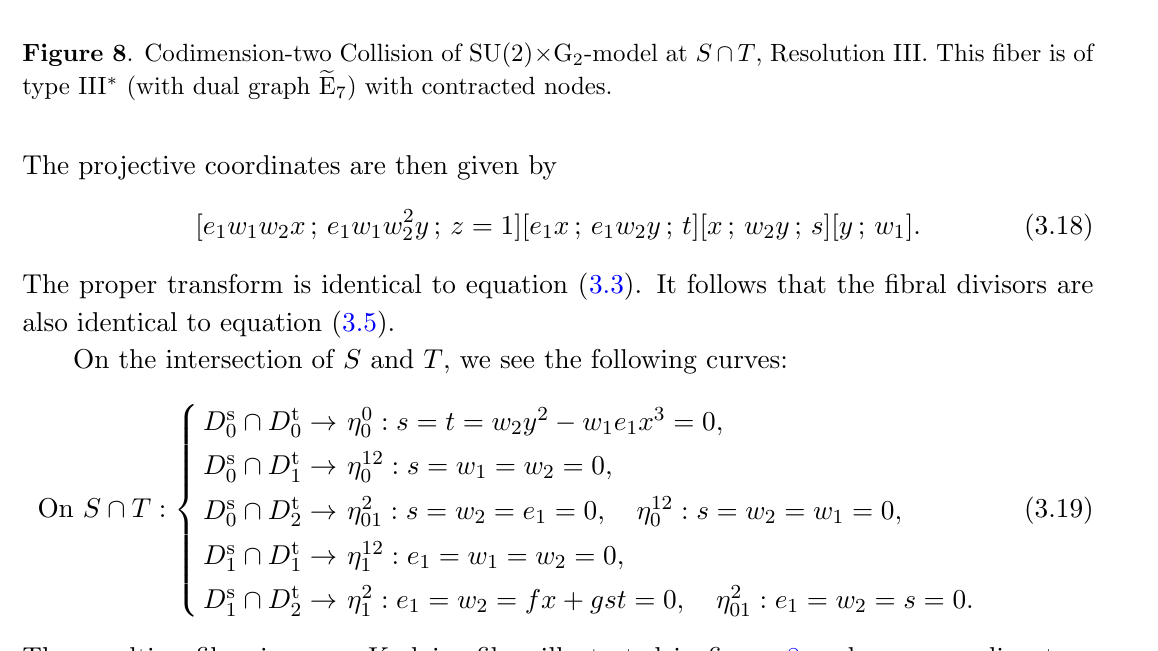
Figure 8 . Codimension-two Collision of SU(2) (cid:2) G type III (cid:3) (with dual graph e E 7 ) with contracted